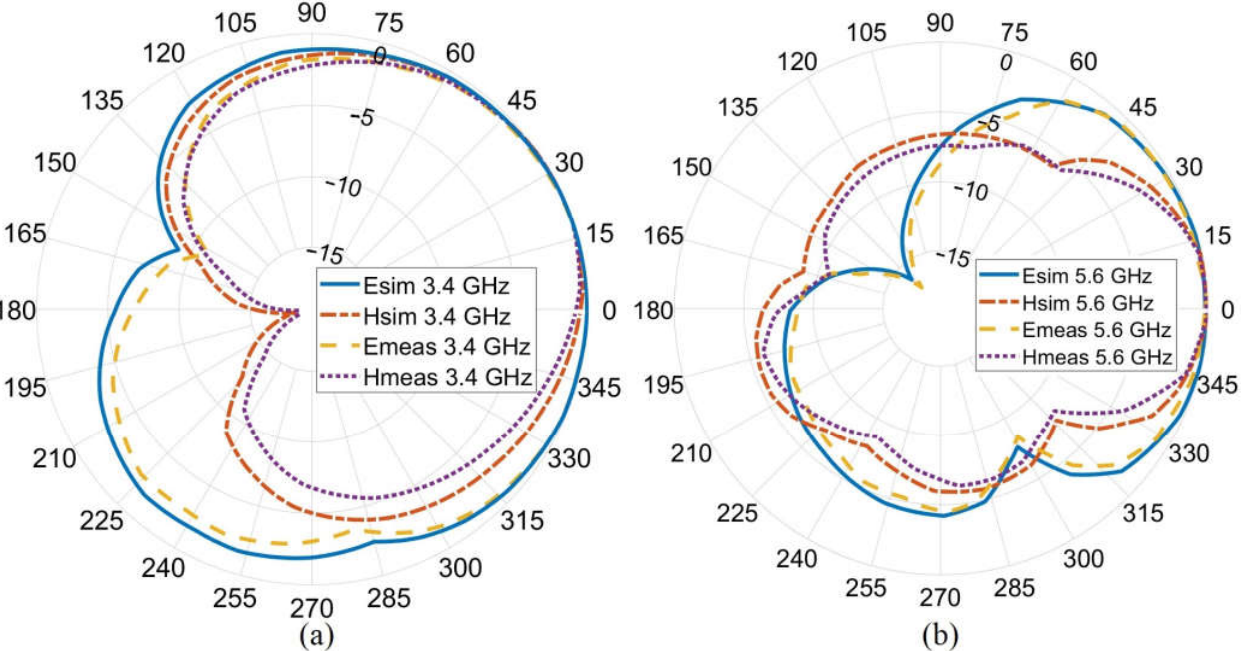
Figure 10. The measurement setup of the antenna to measure the radiation pattern.